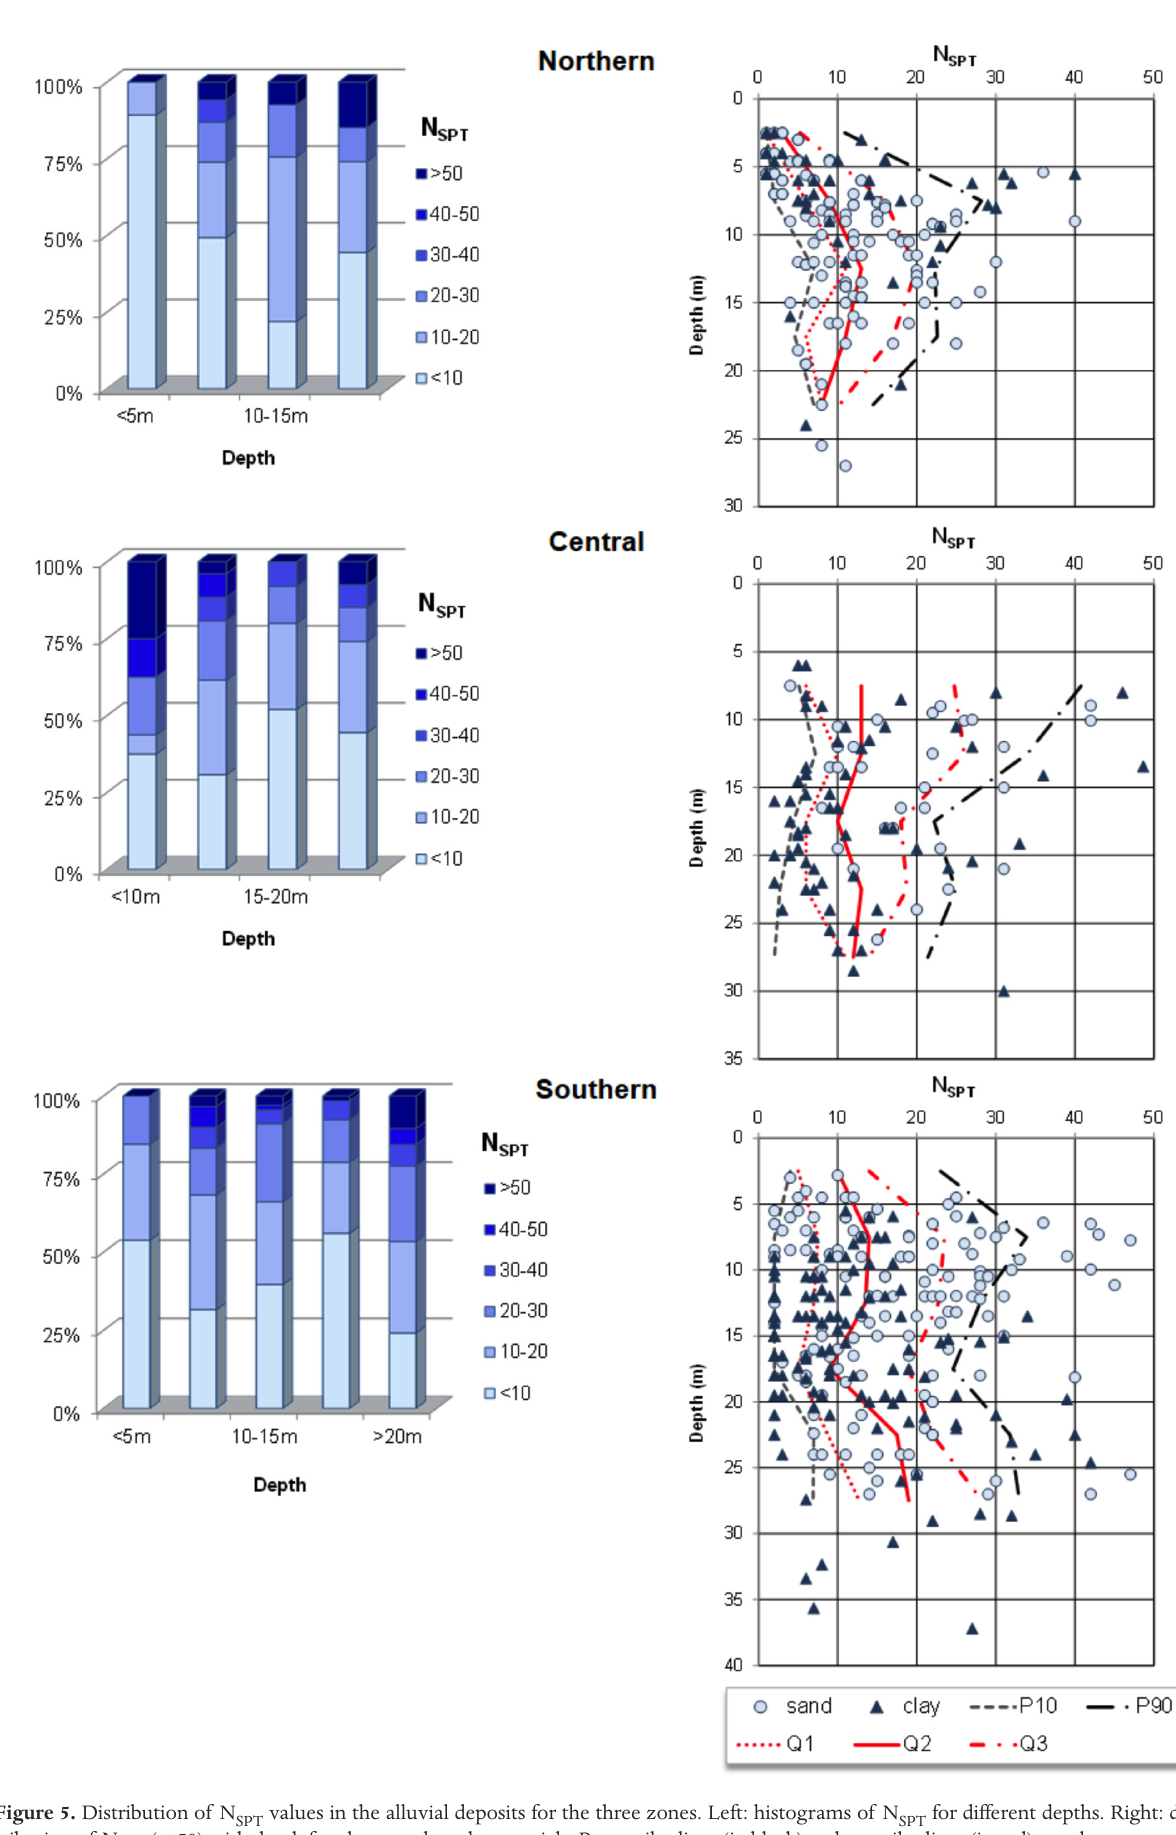
values in the alluvial deposits for the three zones. Left: histograms of N Figure 5. Distribution of N SPT (< 50) with depth for clayey and sandy materials. Percentiles lines (in black) and quartiles lines (in red) are also tribution of N SPT